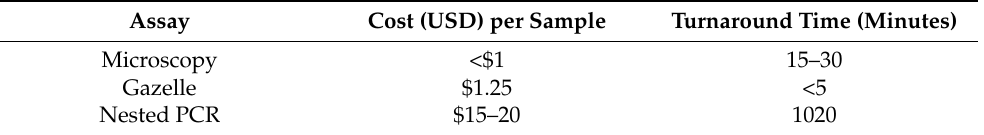
Table 5. Turnaround time and cost analysis considering reagents and supplies. No equipment no labor costs are included. The turnaround time calculation included the sampling time. Assay Cost (USD) per Sample Turnaround Time (Minutes) Microscopy <$1 15–30 Gazelle